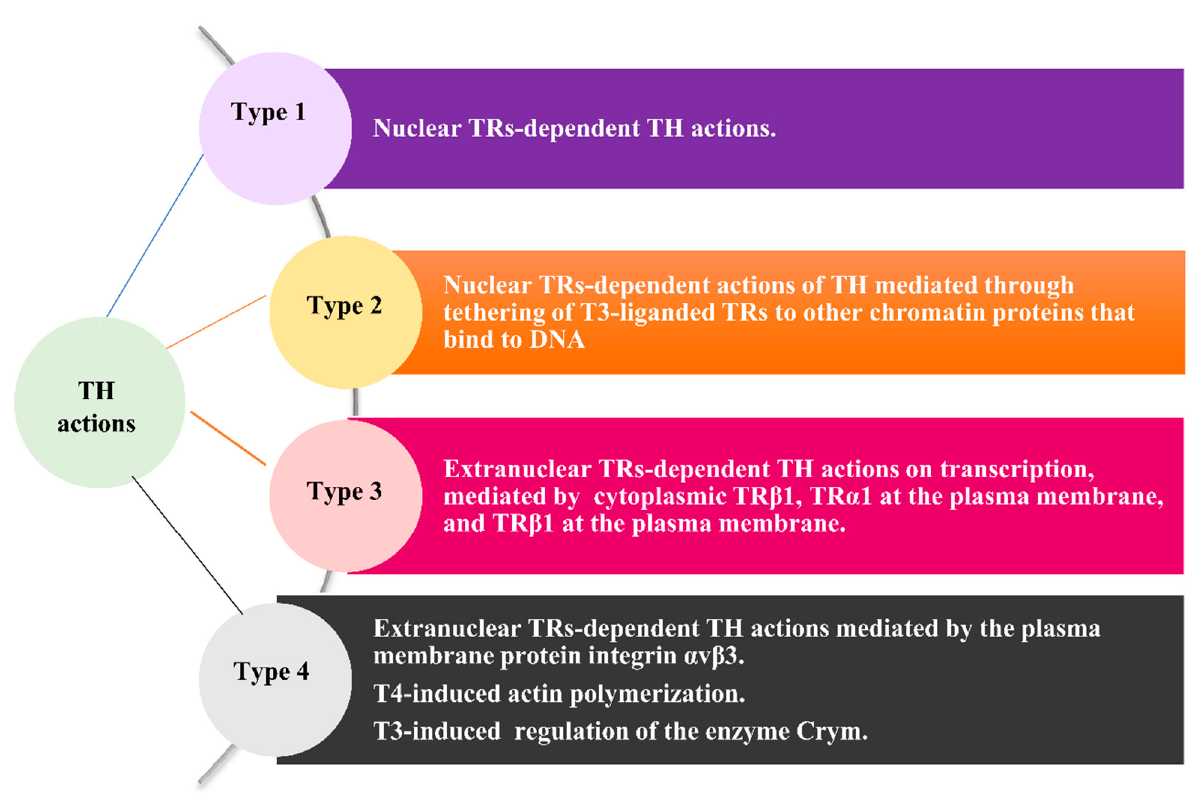
Figure 1. The four types of THs actions. Abbreviations: Τ 3, 3,5,3 ′ -triiodo-l-thyronine; T4, 3,3 ′ ,5,5 ′ - tetraiodo-L-thyronine; THs, thyroid hormones; TR(s), thyroid receptor(s); TR α 1, TR type alpha iso- form 1; TR β 1, TR type beta isoform 1.